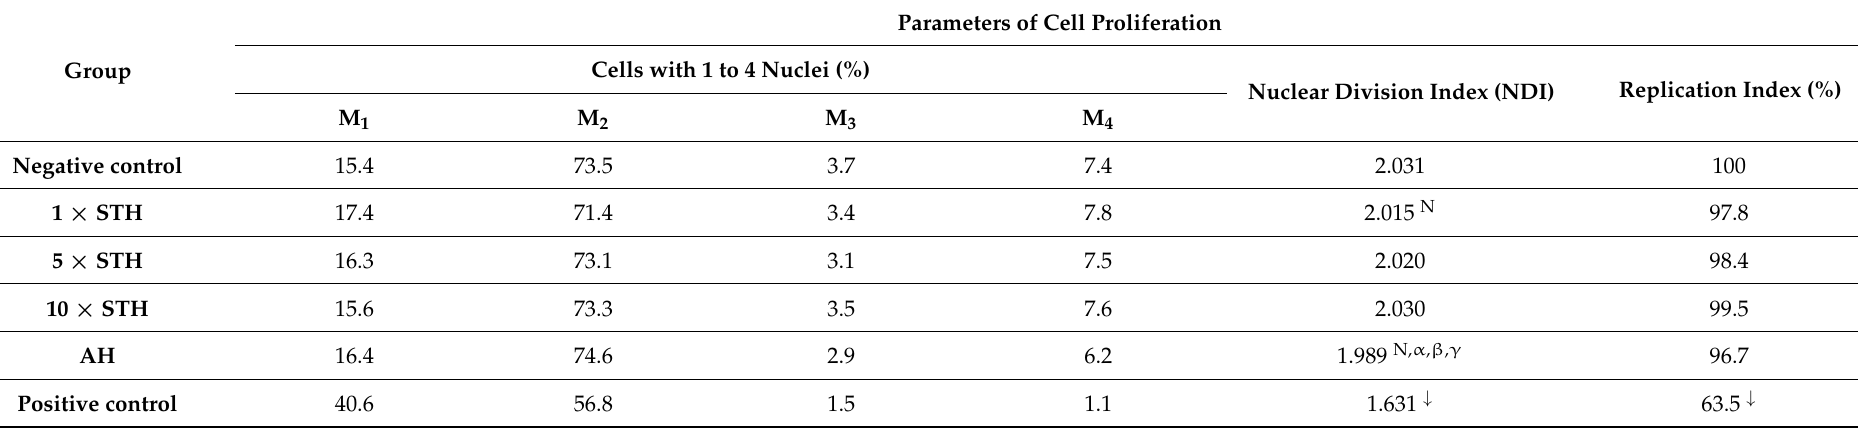
Table 3. Parameters of cell proliferation observed after treatment with strawberry tree honey (STH) and artificial honey (AH). Negative control (non-treated cells) and positive control (bleomycin—15 mg/L) groups were studied in